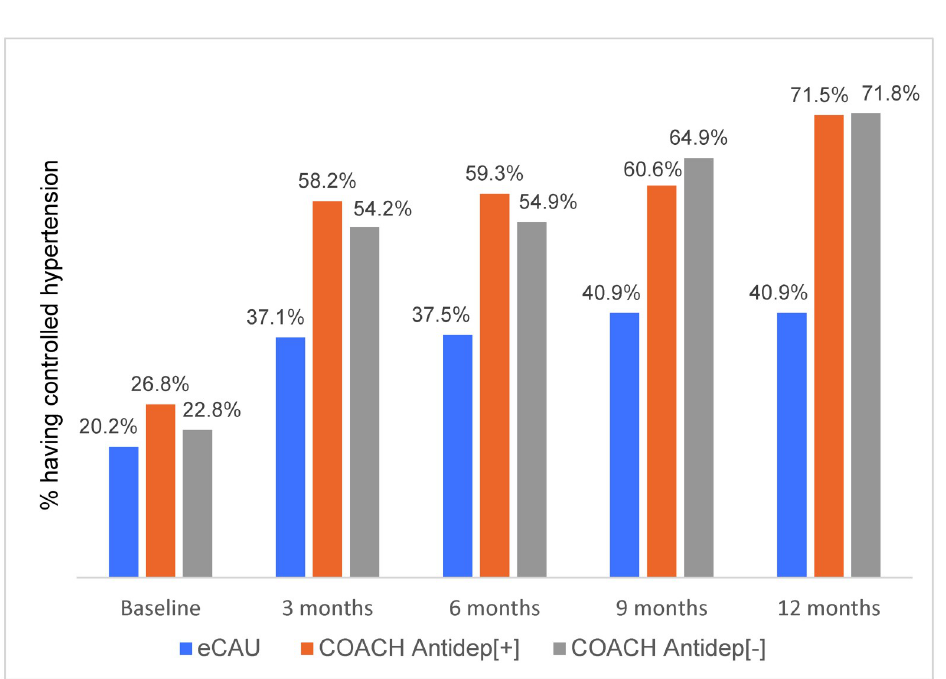
Fig 3. Proportion of participants in 3 groups who achieved HTN control over 12 months. eCAU; COACH participants who accepted antidepressant medications (Antidep[+]); COACH participants who declined antidepressant medications (Antidep[ − ]). COACH, Chinese Older Adult Collaborations in Health; eCAU, enhanced care-as-usual; HTN, hypertension.